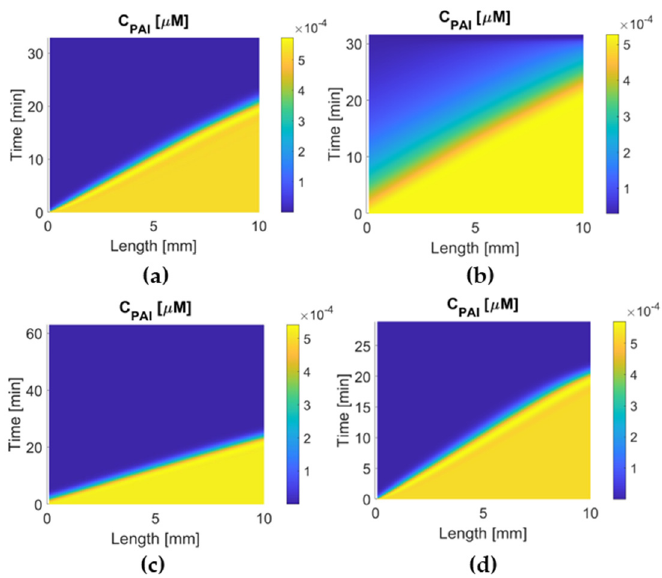
Figure 9. Temporal and spatial concentration profiles of PAI-1 for ( a ) alteplase, ( b ) tenecteplase, ( c ) reteplase, and ( d ) urokinase in the clot.